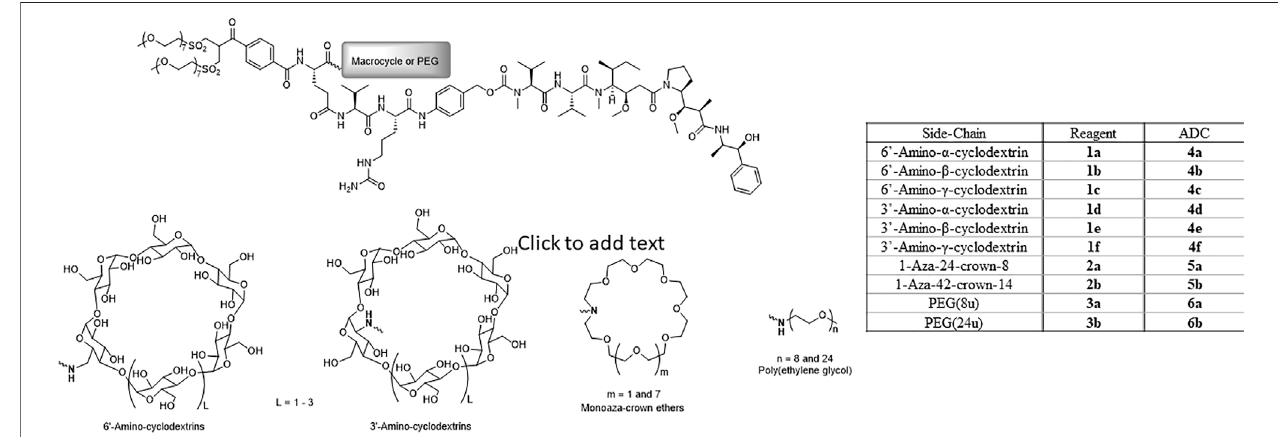
TABLE 1 | In vitro cell viability assay results for ADCs 4a-f , 5a-b , 6a-b , Adcertis ®